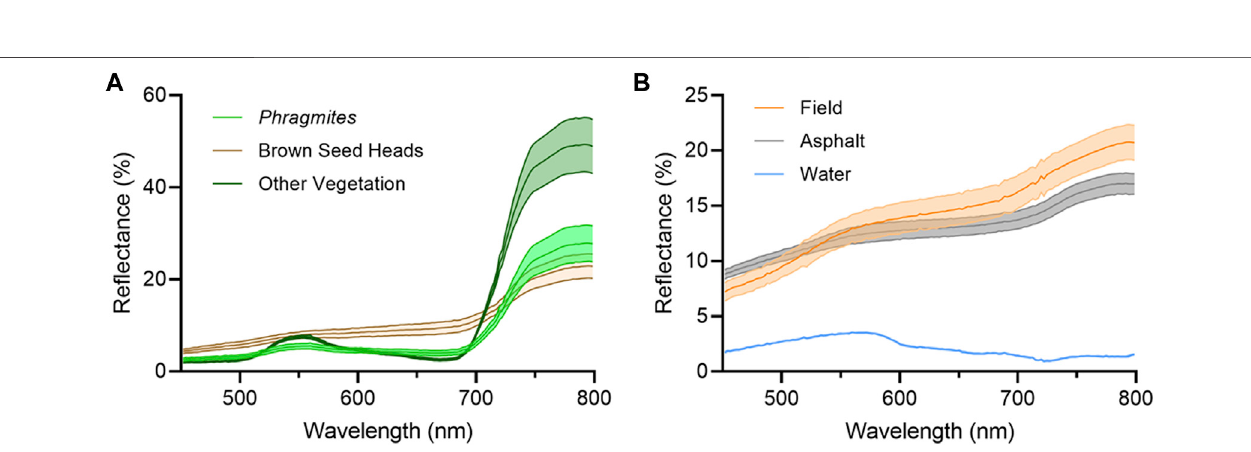
FIGURE 7 | The mean spectra ( ± σ ) of each material type used to train the target detection algorithm (A) Phragmites , the brown seed heads, and other non- Phragmites vegetation (B) agricultural fi elds, asphalt roads, and water.